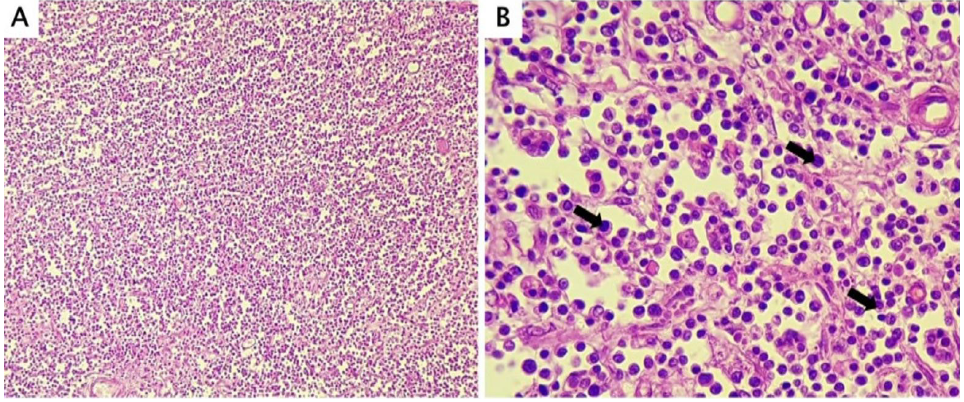
Figure 3. Microscopic view of the mass; Hematoxylin and Eosin staining. (A) Atypical lymphoid proliferation (10x); (B) Examples of lymphoid proliferation characterized by small round cells, with peripheral hypercolor nuclei and scarce eosinophilic cytoplasm (arrows)